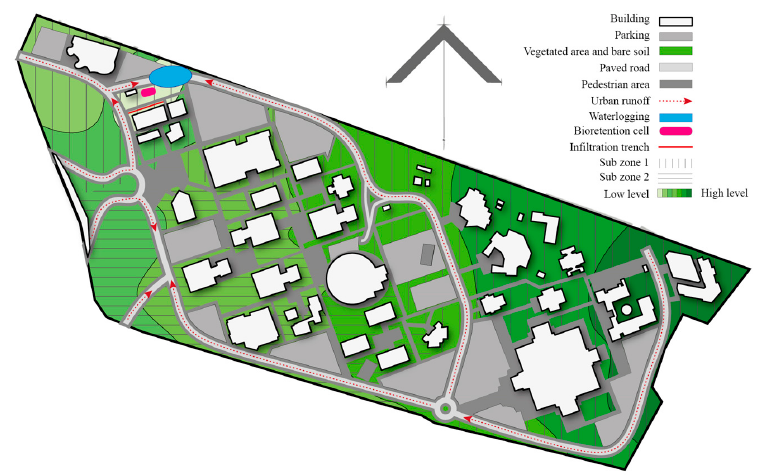
Figure 2. Delimitation of the university campus. It divides into two sub-zones (S1 and S2). S1 was chosen for the hydrologic design of the bioretention cell due to its lowest topographic level. Table 1. General characteristics of the university campus and the sub-zone 1 (S1).